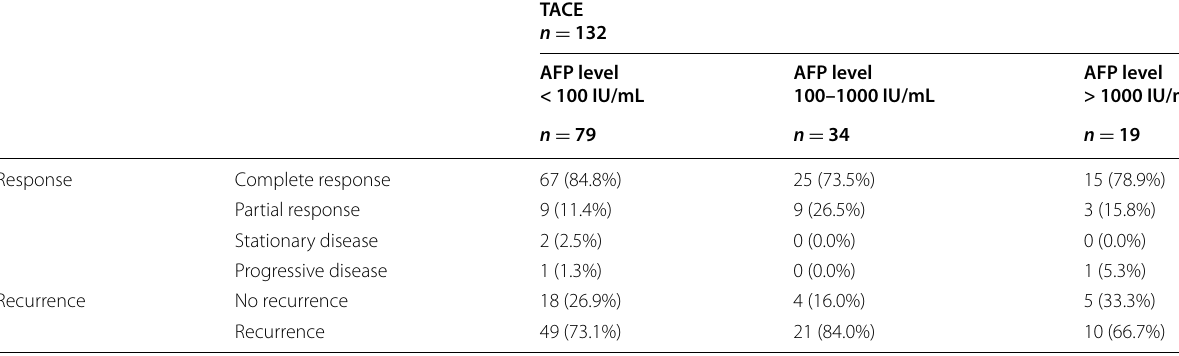
Table 5 Response and recurrence in different AFP levels in the studied patients